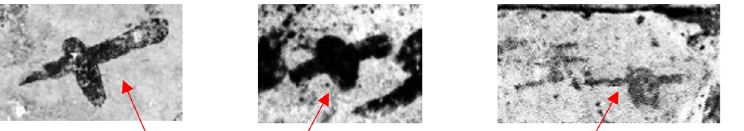
Fig 3. Examples of different shapes, slants, relative length, width and intersection points of the horizontal and vertical shaft of the letter taw . Left: Ostracon 7, middle: Ostracon 1, right: Ostracon